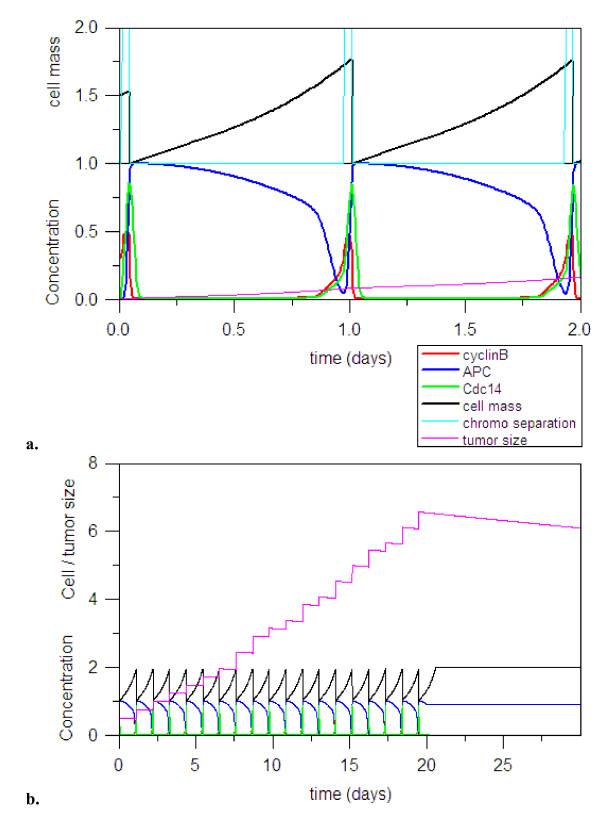
Simulations of the cell cycle from figure 7 using a rule-based model. a. The growth rate of cell mass has a controlling effect on the rest of the cycle. It was set to make the cycle length approximately 1 day, a typical value for human cells undergoing mitosis [60]. The shape and ordering of curves for cyclin B, Cdc14 and APC are very similar here to those shown in Tyson's cell cycle model [59]. The cell mass ranges between 1.0 and 2.0. Chromosome separation is a discrete event that is either on or off. For clarity, the curve was shifted up by one unit in the graph. Another discrete event, cell division, is not shown here. b. Tumor growth in this model is controlled directly by the cell cycle. The rule is: tumor growth is incremented whenever cell division occurs. Thus, if the cell cycle stops, tumor growth stops. Tumor growth is also faster when the cell cycle period is shorter. Tumor cell apoptosis occurs at a constant rate. Tumor size has a large range of values, 0 to 100 in arbitrary units, to allow virtually unlimited tumor growth in model runs.